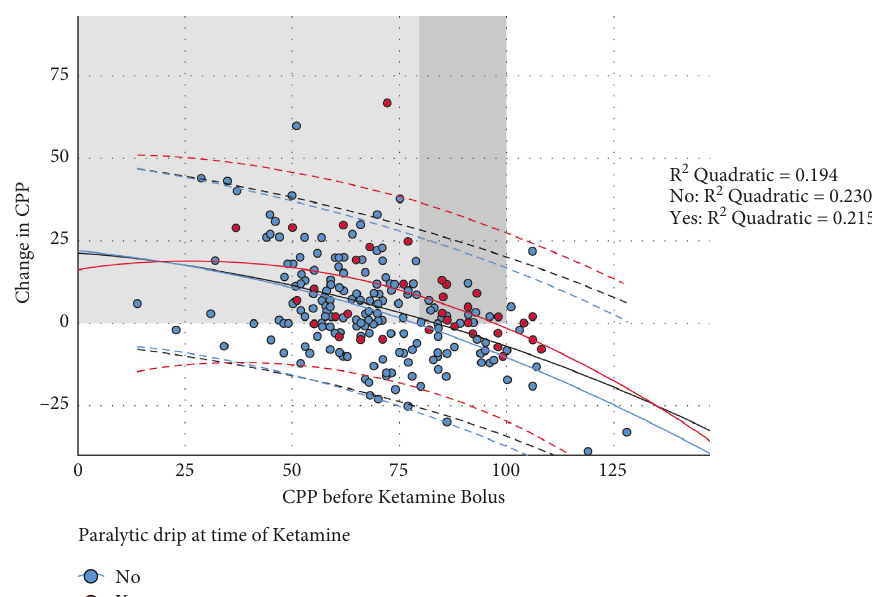
Figure 2: Change in CPP after ketamine bolus according to baseline CPP levels. The blue circles represent patients without paralytic drips, whereas the red circles are those with paralytic drips. The bold lines are the regression lines (black for the whole population and red and blue for those with and without paralytic drips, respectively), whereas the dashed lines are the 95% confidence intervals around the regression lines. The gray zone represents events where the CPP increased according to the regression model the